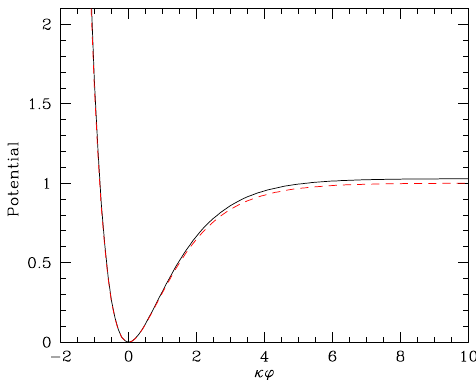
Figure 3. The RVM effective potential ακ 2 U / H 2 (solid line) versus the scalaron field κϕ . In order to I produce the curve, we utilize M ∼ M X ∼ 10 16 GeV, H I ∼ 0.81 × 10 14 GeV (see Equation (3)) and α ∼ 10 − 4 . The dashed line corresponds to the Starobinsky effective potential (see Figure